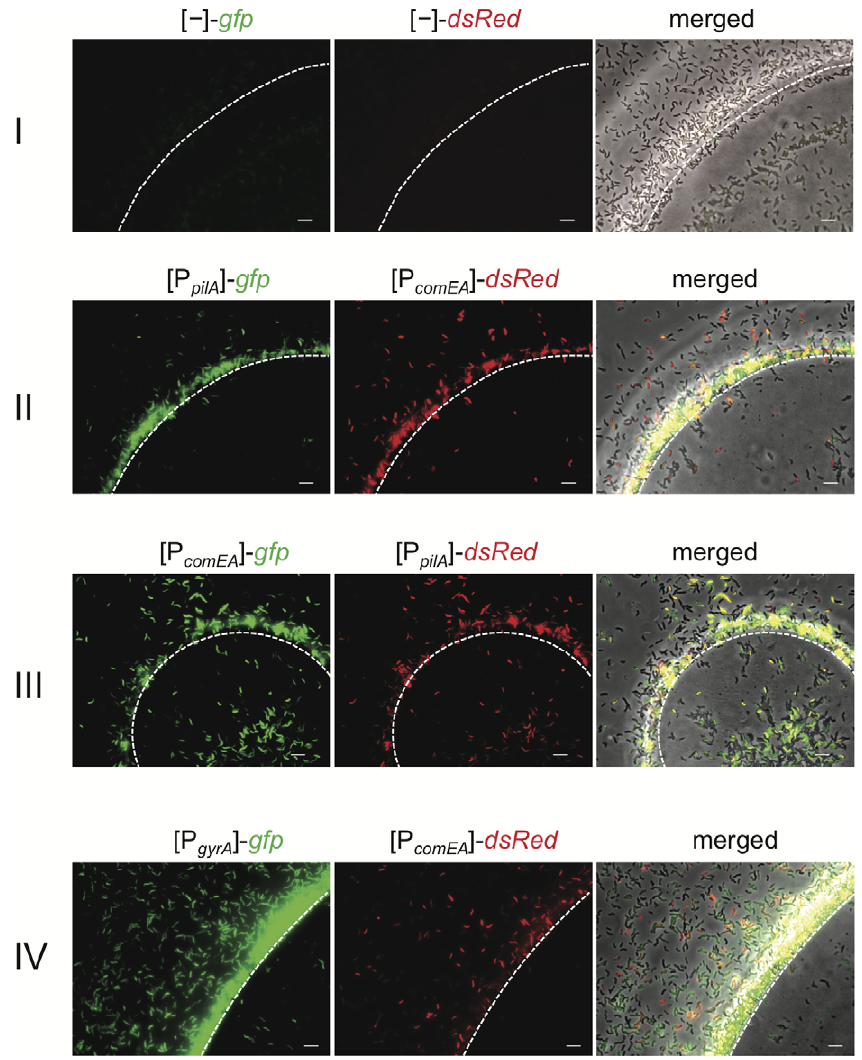
Figure 1. Visualization of competence gene expression on chitin surfaces. V. cholerae cells were grown on chitin beads as previously described [23]. The white dashed line notes the edge of the chitin surface. The bacteria carried diverse transcriptional FP reporter fusions. I: vector control containing promoter-less gfp and dsRed ; II: plasmid containing gfp driven by the pilA promoter and dsRed downstream of the comEA promoter region; III: swapped reporter genes in comparison to II; IV: plasmid containing gfp driven by the gyrA promoter and dsRed driven by the comEA promoter. Bacteria were grown statically for 48 h before pictures were taken. The order of the images here and in the following figures is (from left to right): green channel (GFP), red channel (dsRed), and merged image composed of a phase contrast image overlaid by both fluorescence channel images. Scale bar=5 m m.